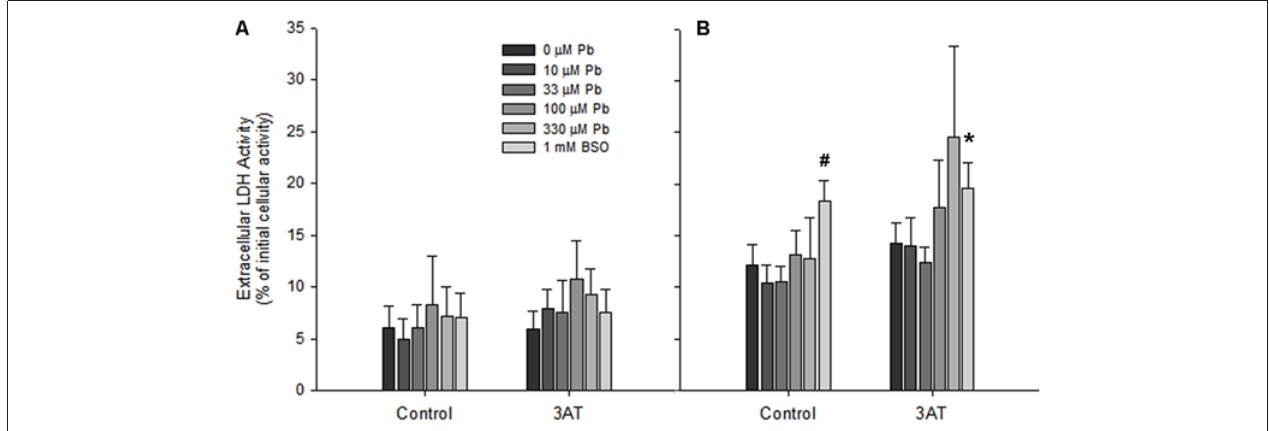
FIGURE 5 | Cell viability in rat astrocyte cultures before and after 100 µ M H 2 O 2 treatment. Incubation conditions were the same as in Figure 3 . (A) Extracellular LDH immediately before application of 100 µ M H 2 O 2 . (B) Extracellular LDH 60 min after application of 100 µ M H 2 O 2 . Significant differences ( p < 0.05) between treatments and the untreated controls are represented by # for the no-3AT control group, and by ∗ for the 3AT group. Each bar represents a mean ± SD of n = 9 samples, except for those treated with 10 µ M lead where n =